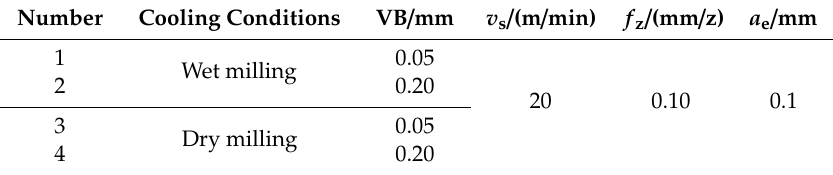
Figure 3. Tool flank wear. ( a ) VB = 0.05 mm, ( b ) VB = 0.20 mm. Table 3. Processing conditions of side milling.